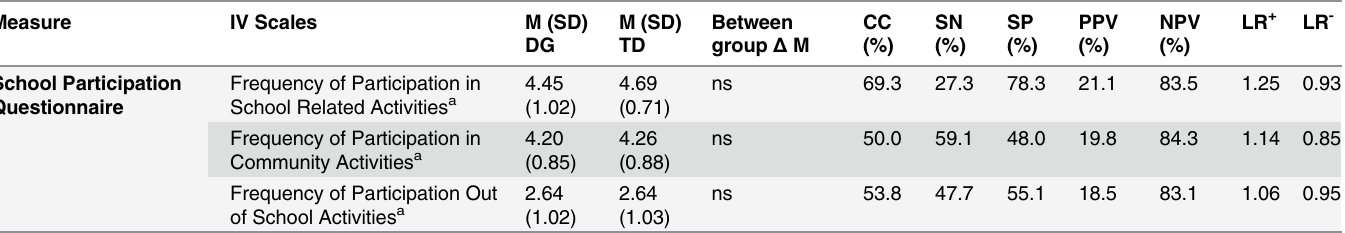
Table 3. Ability of the students ’ extra-curricular activity participation profiles to differentiate disability in a community mainstream school sample.